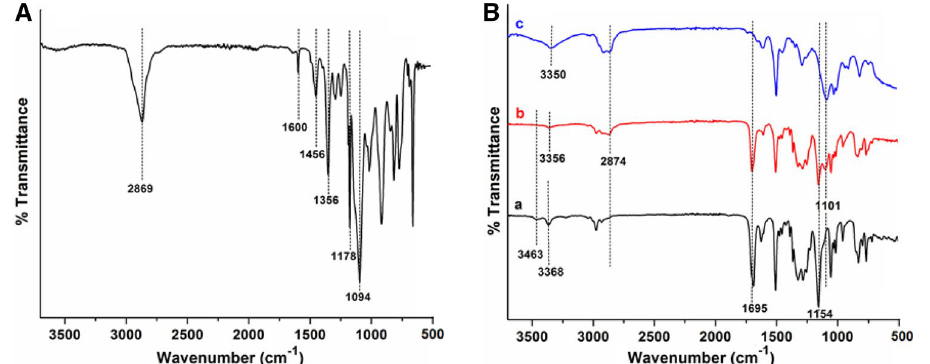
Figure 2. FTIR spectra ( A ) mPEG 2k -tosylate, and ( B ) TANI (a), P2 (b), and P2L